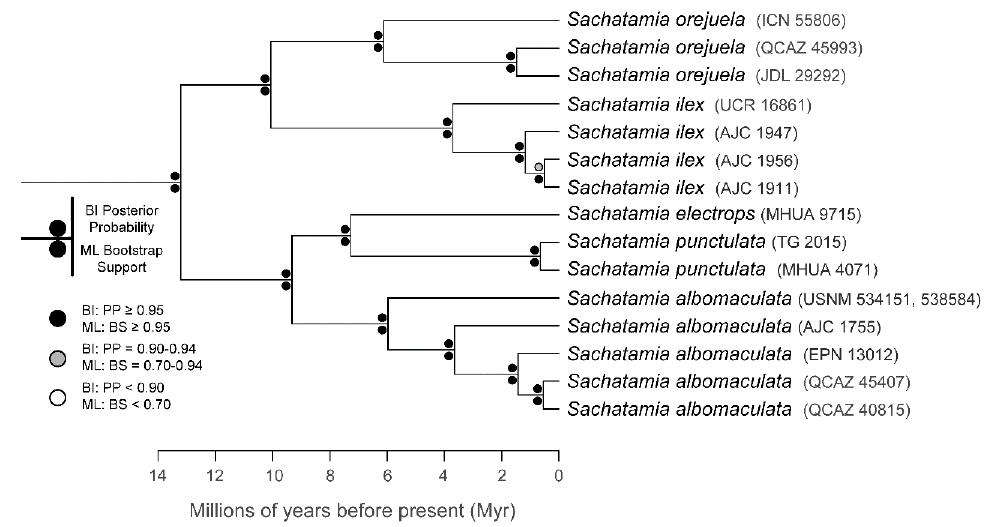
Figure 204. Evolutionary relationships of species in the glassfrog genus Sachatamia . The trees were inferred using maximum likelihood and Bayesian criteria.